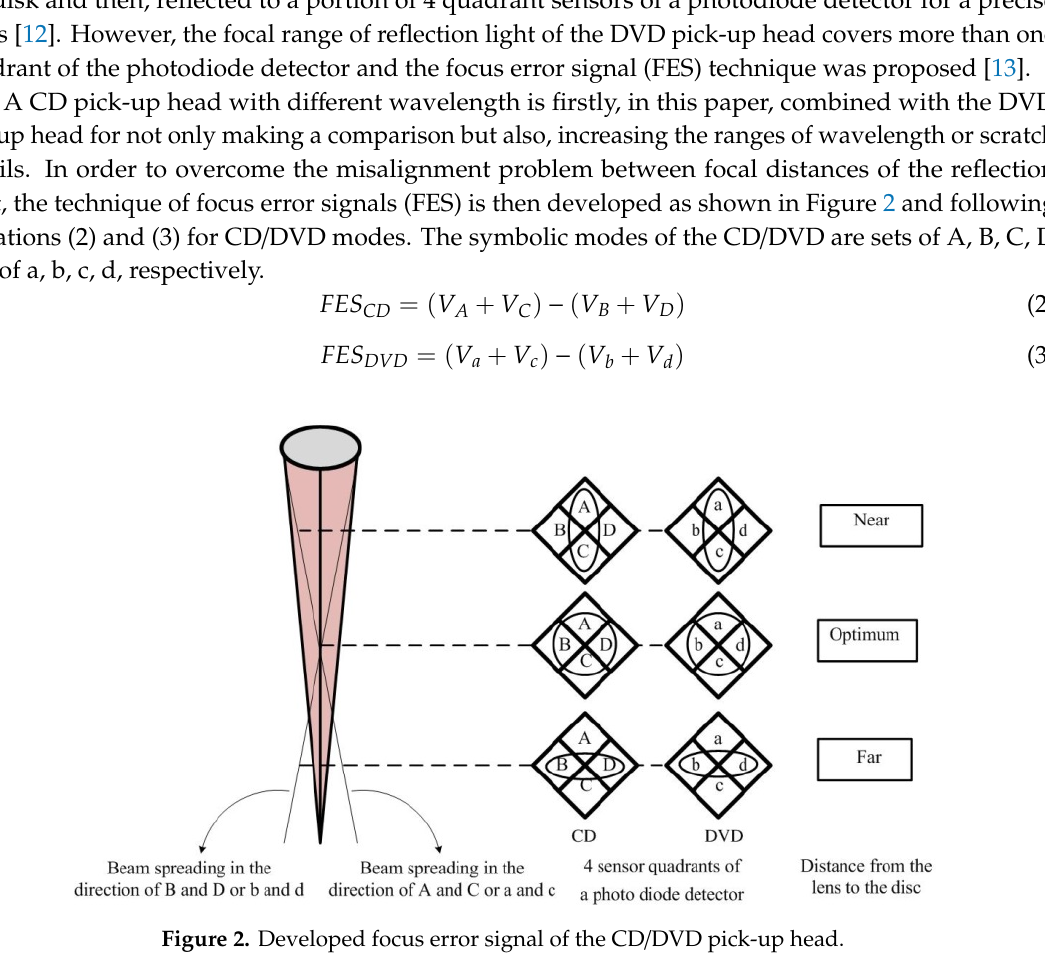
Figure 1. Measurement of scratch width and position using developed CD/DVD pick-up head.